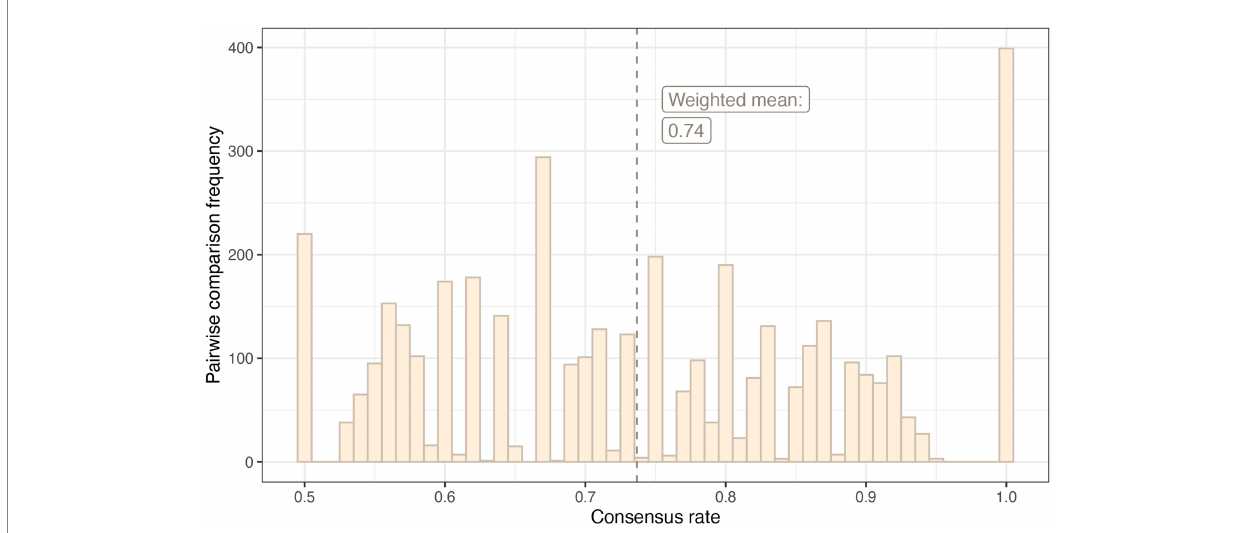
FIGURE 5 A histogram demonstrating the frequency of pairwise comparisons per consensus rate in the main survey.